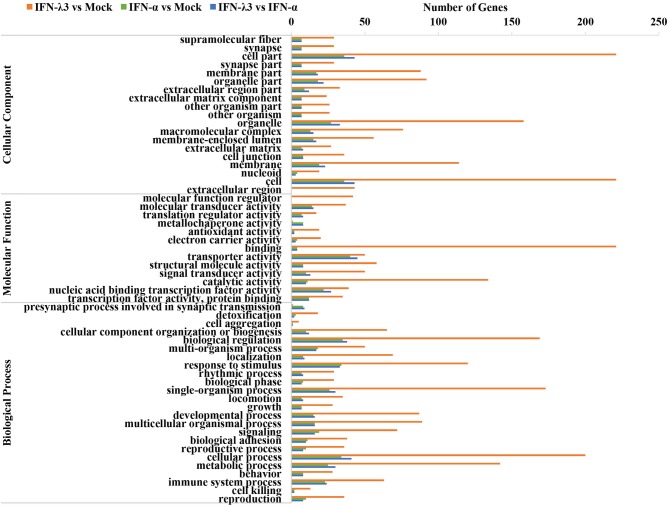
GO enrichment analysis of IFN-λ3 or IFN-α targets.